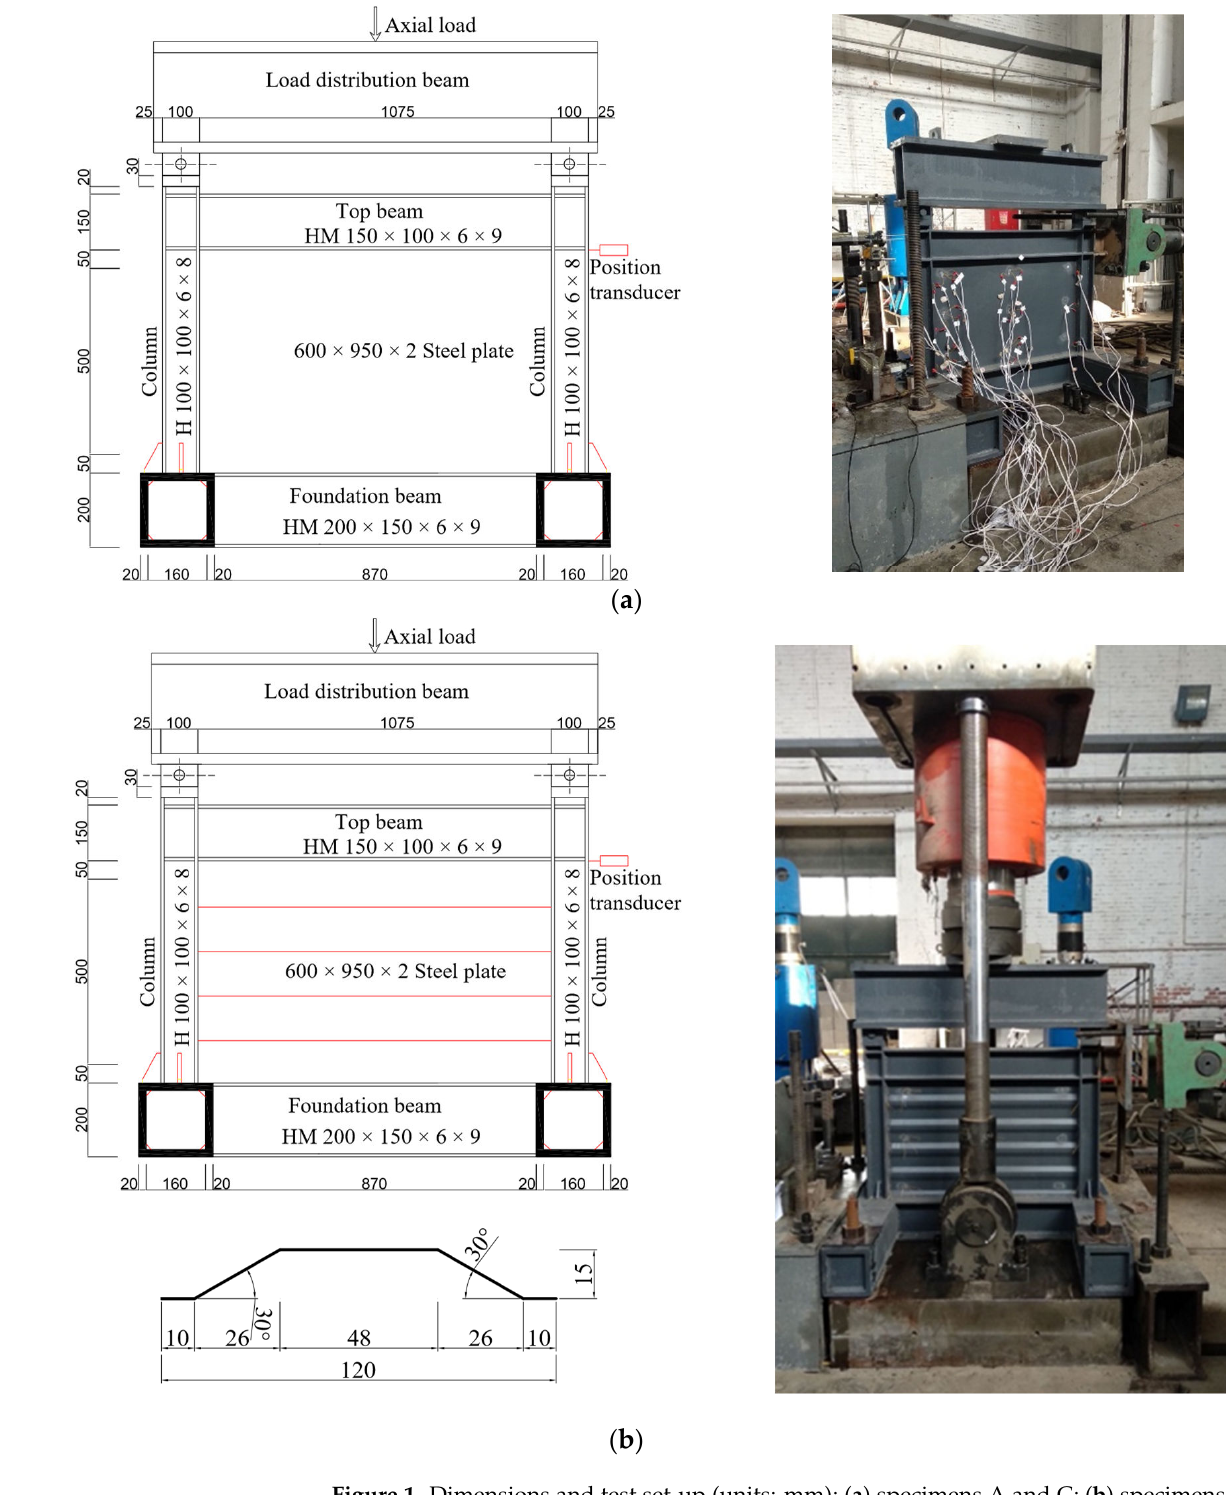
Figure 1. Dimensions and test set-up (units: mm); ( a ) specimens A and C; ( b ) specimens B and D (Adapted with permission from Ref. [22]. Copyright 2022 Springer Nature.).